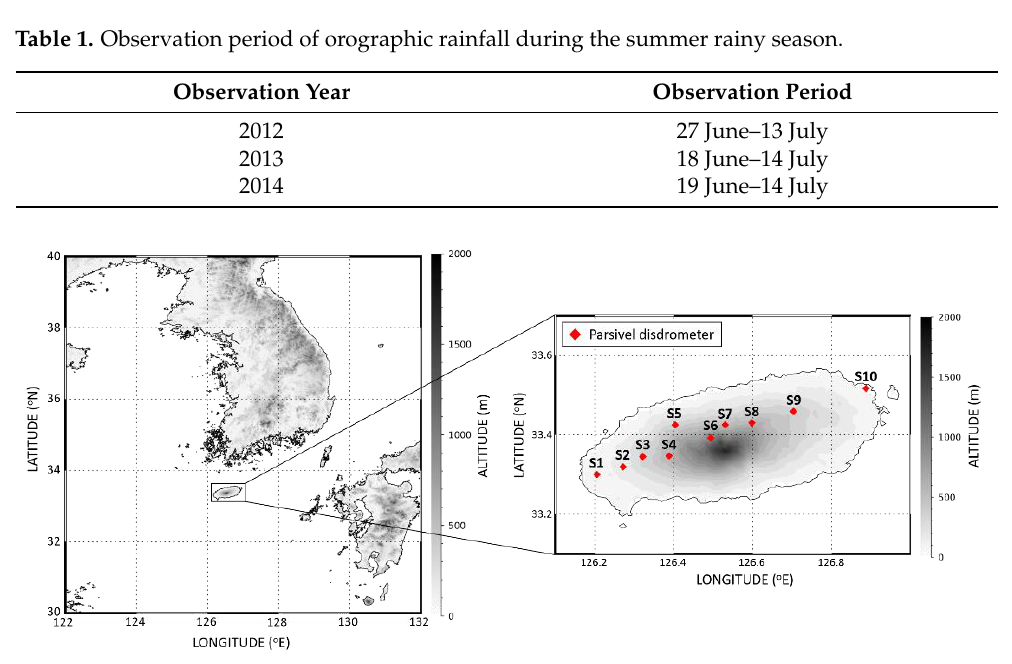
Figure 1. The observation site map. The red colored diamonds indicate Parsivel sites. The gray contour shows the topography (contour interval: 200 m). Table 2. Information on the location and altitude of the Parsivel observation sites on the slope of Mt. Halla on Jeju